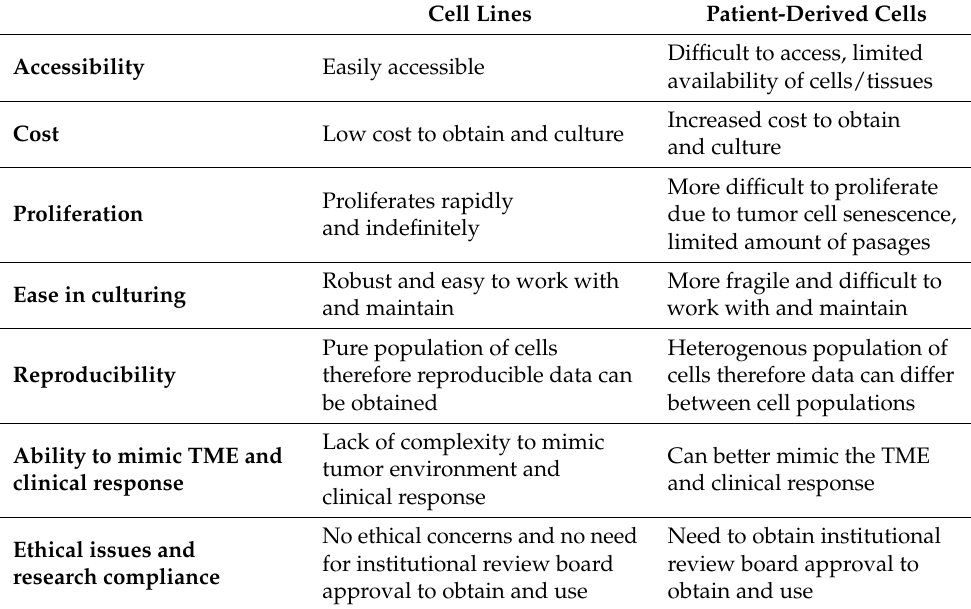
Table 1. Comparison of cell lines vs. patient-derived